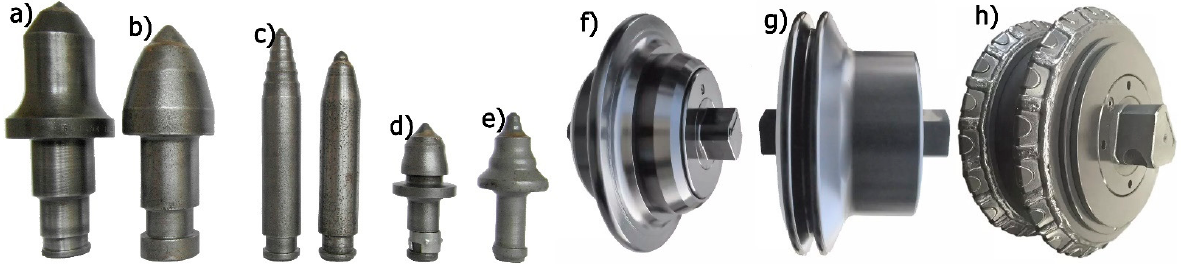
Figure 1. Cutting tools: ( a ). conical picks of longwall shearers, ( b ). conical picks of road headers, ( c ). conical picks of salt mining machines, ( d ). conical picks of concrete milling machines, ( e ). conical picks of milling machines for asphalt road surfaces, ( f ). symmetrical discs, ( g ). asymmetric double discs, and h . reinforced discs ( a – e ) [9], ( g – h ) [25]).